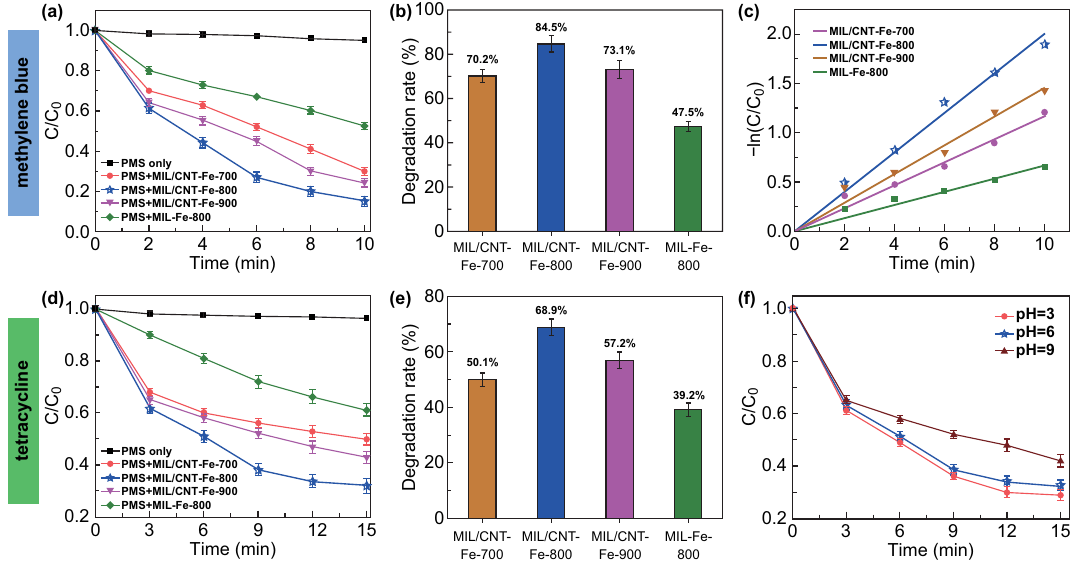
Fig. 5 a The degradation of MB in different reaction systems. b Degradation rates (%) of MB with different catalysts in 40 min. c Kinetic lin- ear fitting for the removal of MB, d The degradation of TC in different reaction systems. e Degradation rate (%) of TC with different catalysts in 15 min. f Contrast experiment of different pH for TC degradation using MIL/CNT–Fe-800. Reaction conditions: [MB or TC] = 20 mg L −1 , [PMS] = 0.2 g L −1 , catalyst = 0.1 g L −1 , T = 298 K, initial pH =